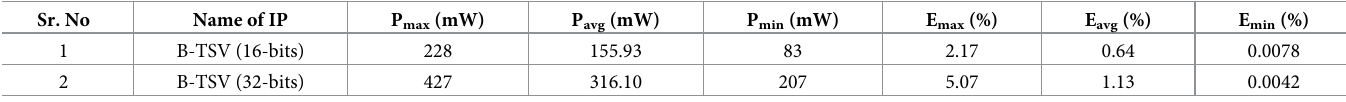
Table 5. Power estimates and accuracy for